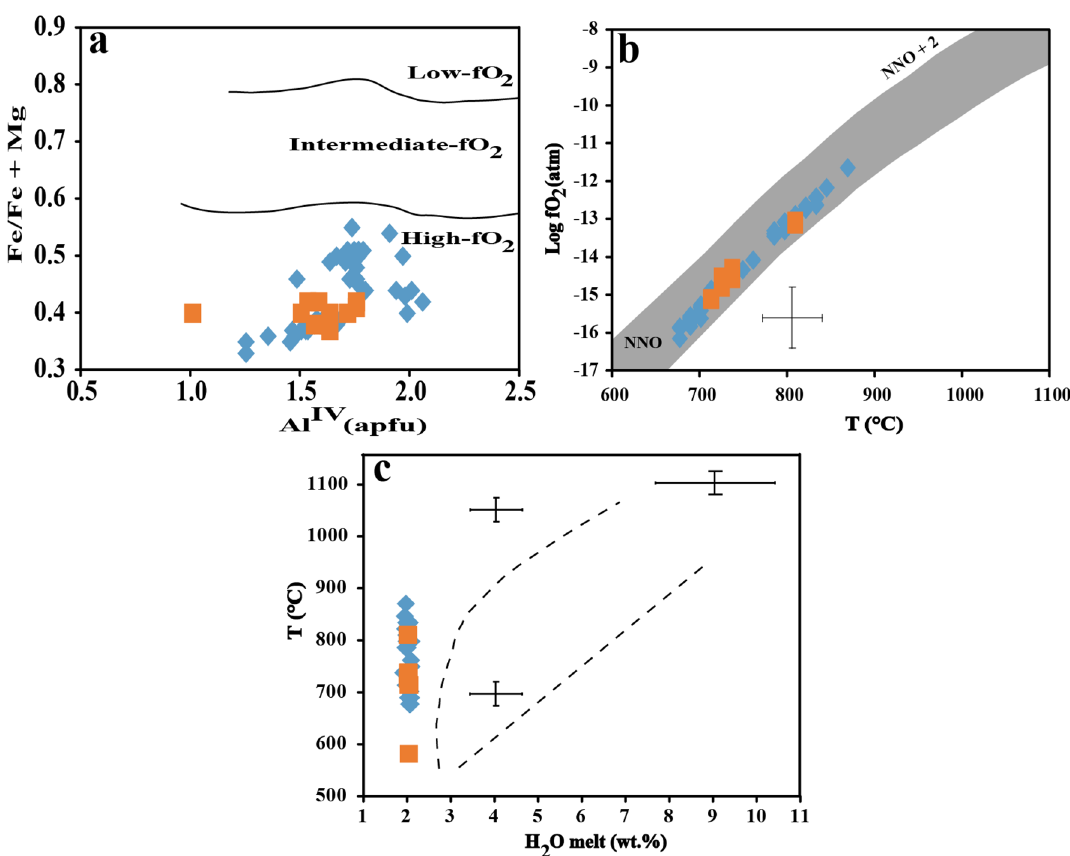
The maximum thermal stability (black dotted line at the left) and Fig. 6 a Al IV (apfu) vs. Fe/Fe + Mg diagram showing the composi- the lower limit (black dotted line at the right) of consistent amphi- tional variation of amphiboles [64], b T (°C) vs. log f(O ) diagram of 2 boles are also reported. For more explanations, see [66]. Symbols amphiboles after [62, 66]. The NNO and NNO + 2 curves in ( b ) are are the same as in Fig. taken from [67], c H O melt (wt%) vs. T (°C) diagram (after [66]). 2 Error bars in ( c ) indicate the variation in accuracy with H O melt. 2